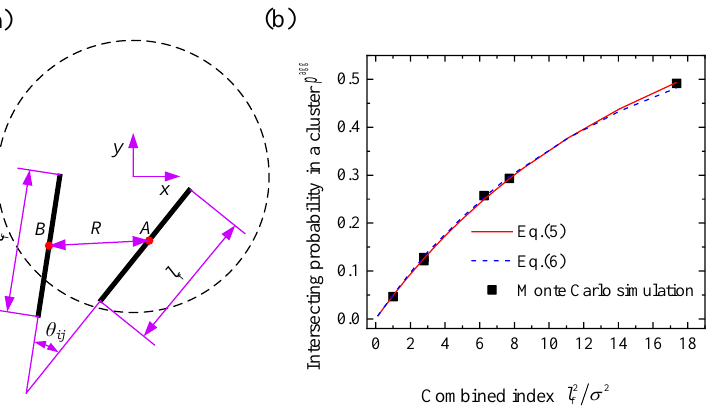
Figure 2. ( a ) A schematic diagram of two arbitrary fibers in an aggregating cluster and ( b ) the intersecting probability vs. combined index ( l 2